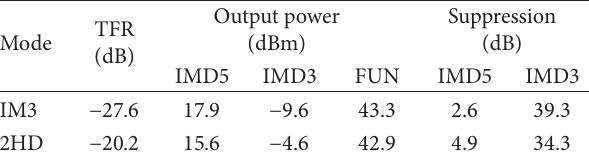
Table 2: The output power and corresponding TFR under IM3 injection and 2HD injection in